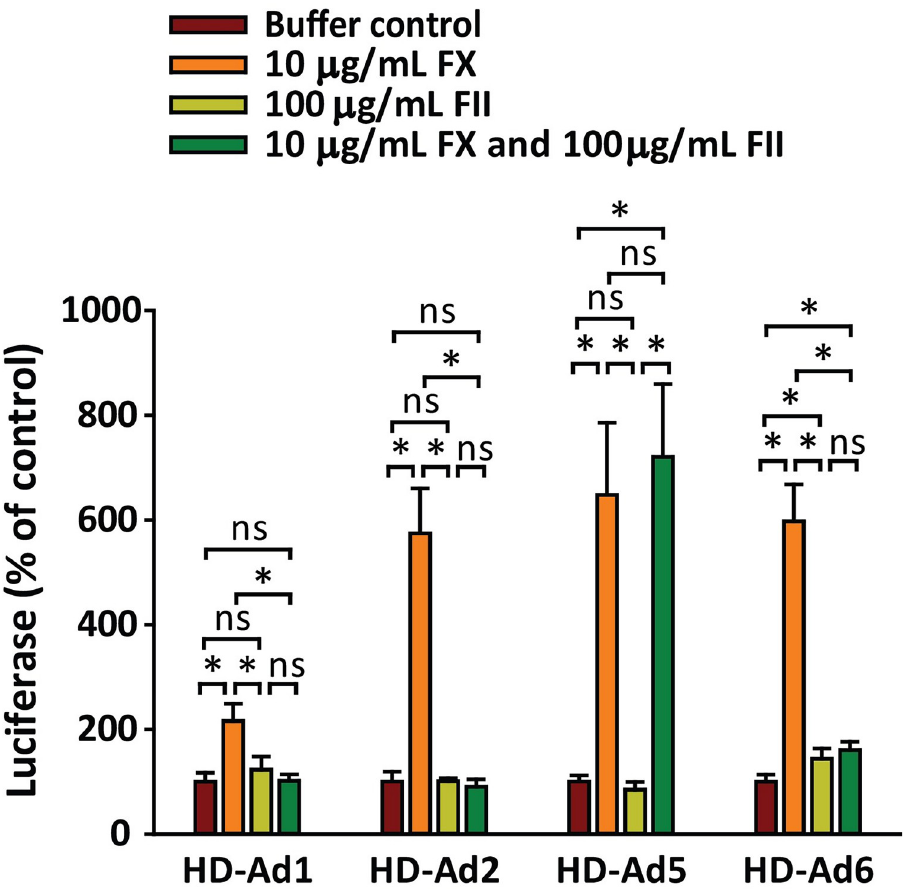
Fig 5. Enhancement of cellular transduction by human FX, but not human FII. SKOV3 cells were transduced with HD-Ad vectors in the presence of physiological concentrations of human FX (10 μ g/mL), human FII (100 μ g/mL), or both. Luciferase expression was measured 24 h later. n = 3 per group. Statistical differences were evaluated by ANOVA and Holm-Sidak post-hoc test ( � P � 0.05).